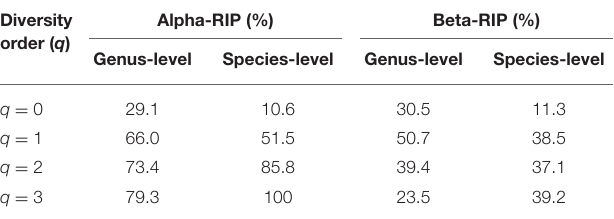
TABLE 5 | RIP (ratio of individual diversity to population maximal accrual diversity). Diversity Alpha-RIP (%) order ( q )